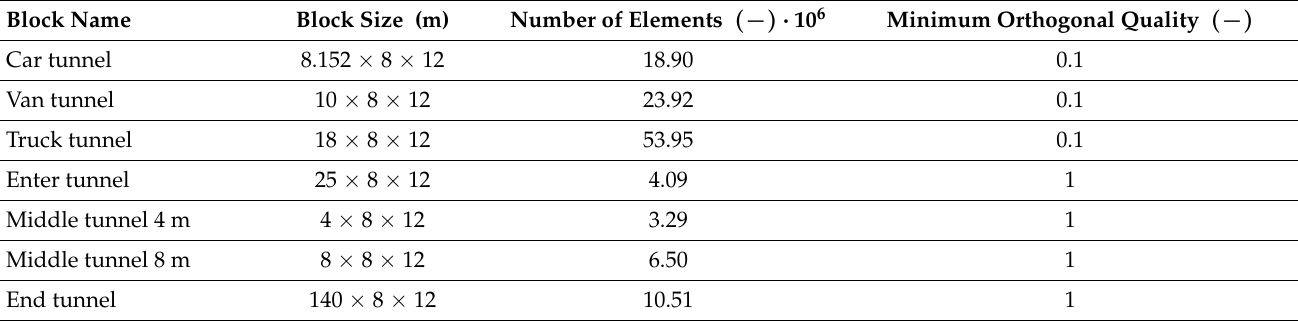
Table 1. Description of mesh blocks.